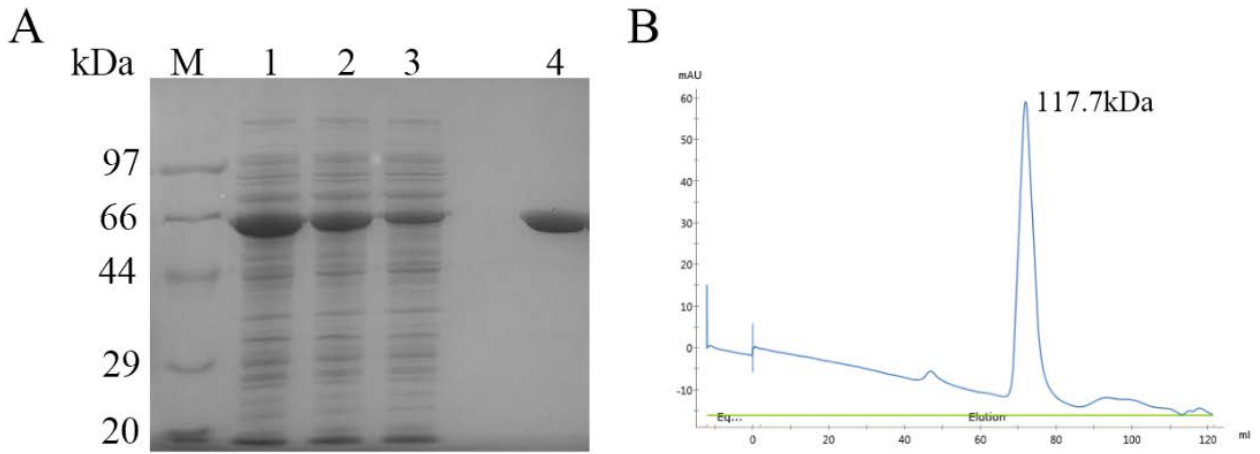
Figure 2. SDS − PAGE ( A ) and size − exclusion gel chromatography ( B ) of purified recombinant Co DPP III. M: molecular weight markers; lane 1: the supernatant fraction; lane 2: the precipitant fraction; lane 3: the flowthrough fraction; lane 4: the elution fraction.